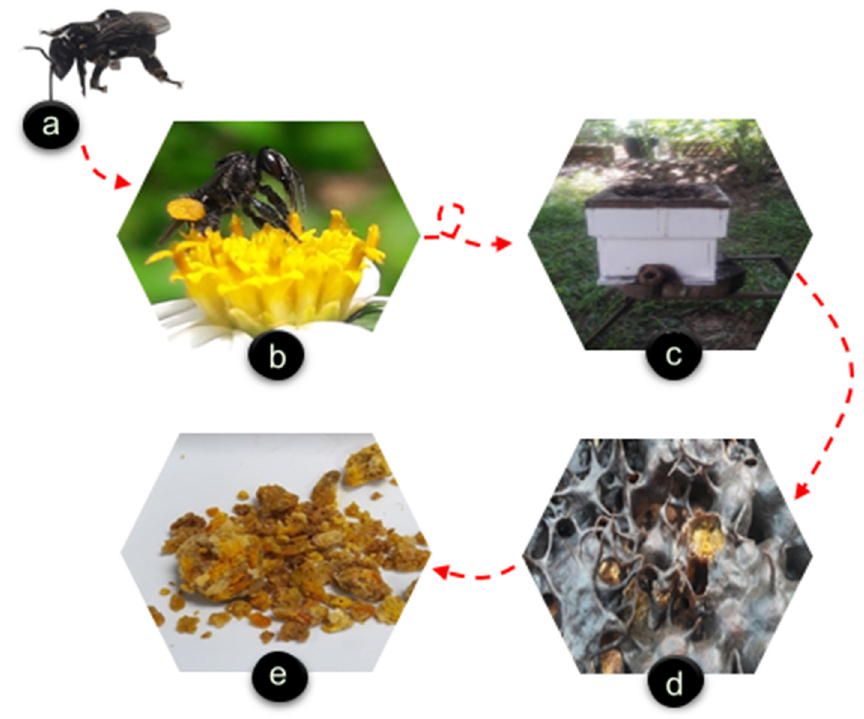
Figure 1. The production of bee bread from flower pollen. ( a ) Stingless bee, ( b ) stingless bee visits flower and collects pollen on its hind leg, ( c ) stingless bee returns to its hive, and ( d ) stores the pollen inside cerumen pots where lactic acid fermentation occurs to form bee bread. ( e ) Collected bee bread. If the bee pollen is not harvested, the worker bees pack the bee pollen inside a cerumen pot (for stingless bee) (Figure 2) or honeycomb cells (for honeybee) made from beeswax and resin. Once the pollen pots are full, the pots are sealed closed [37] before being consumed by larvae or young adult bees as a protein source [2]. During storage, lactic acid fermentation takes place to transform bee pollen into bee bread [38]. Molecules 2020 , 25 , x FOR PEER REVIEW